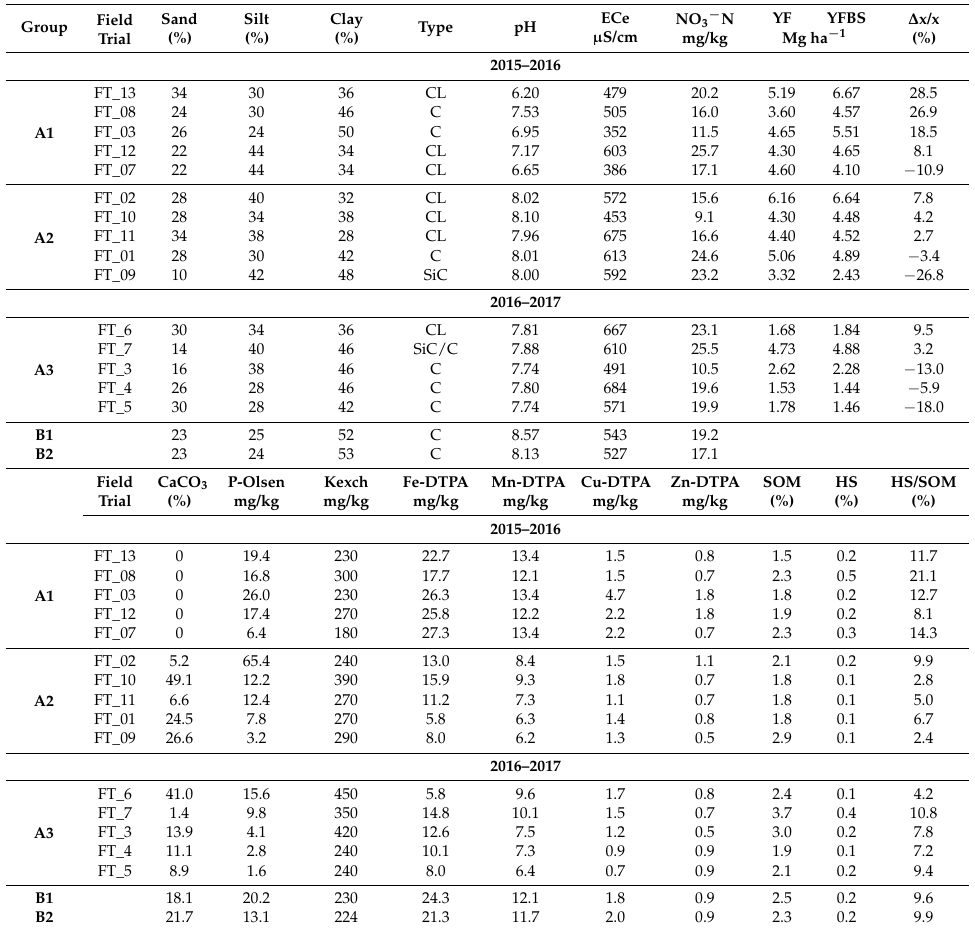
Table 2. Soil analysis data and yields. OM, soil organic matter; HS, soil humic substances; YF, yield of the conventional crop; YFBES, yield of the elemental sulfur treated crop; ∆ x/x, YFBES percentage change relative to